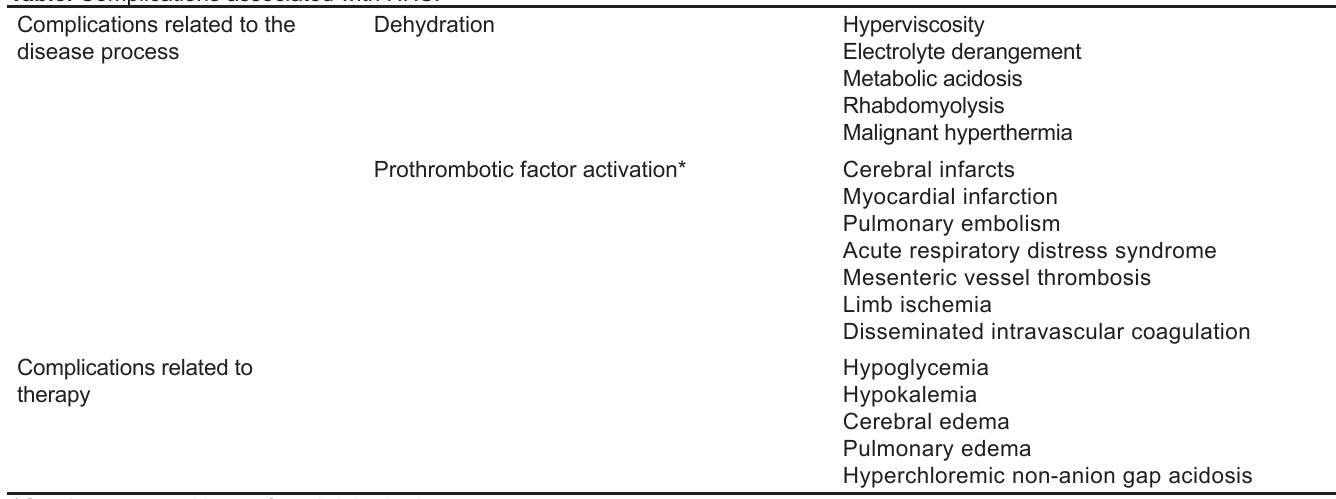
*Can be worsened by profound